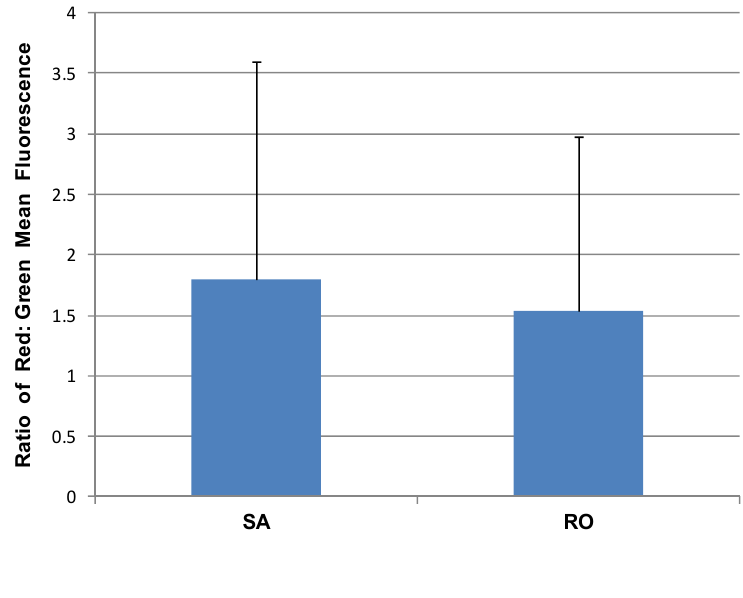
Figure 9. Comparison of the average red: green channel mean fluorescence ratio between chitosan (CHI)/hyaluronan (HA)/fluorescein (6-FAM) DNA films containing sulforhodamine B aptamer (SA) or RO DNA ( N = 8) as an indication of binding. Films were prepared by the modified method of deposition and exposed to 200 µM sulforhodamine B (SB) dye. Error bars represent standard